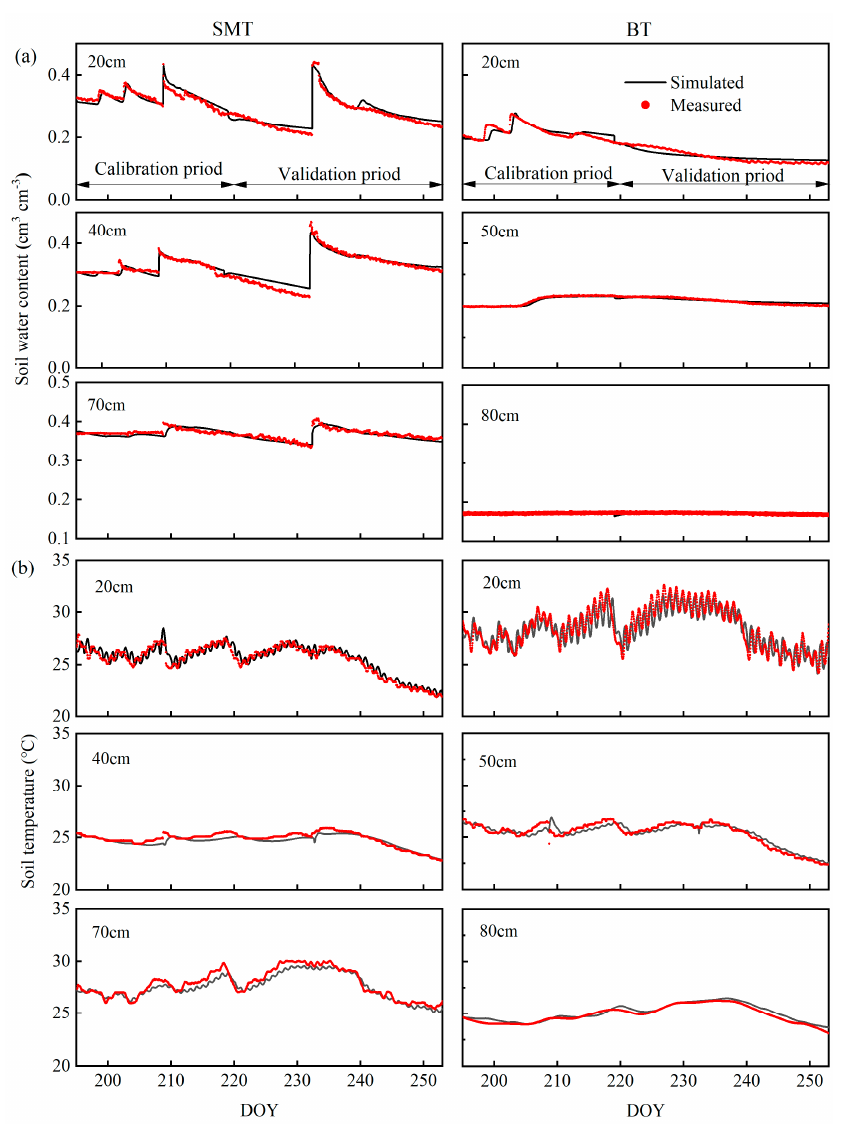
Figure 3. Simulated and measured soil water contents ( a ) and temperature ( b ) at 20, 40 and 70 cm depths for SMT and at 20, 50 and 80 cm depths for BT.